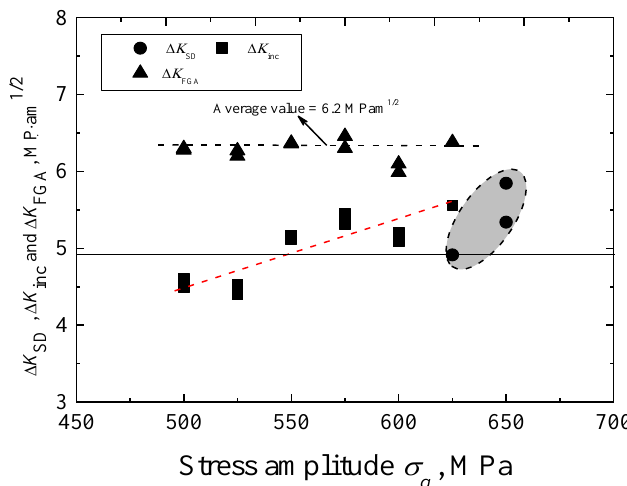
Figure 10. Relationships between stress intensity factor of SD ( Δ K SD ), stress intensity factor of inclusion ( Δ K inc ), stress intensity factor of FGA ( Δ K FGA ) and σ a .